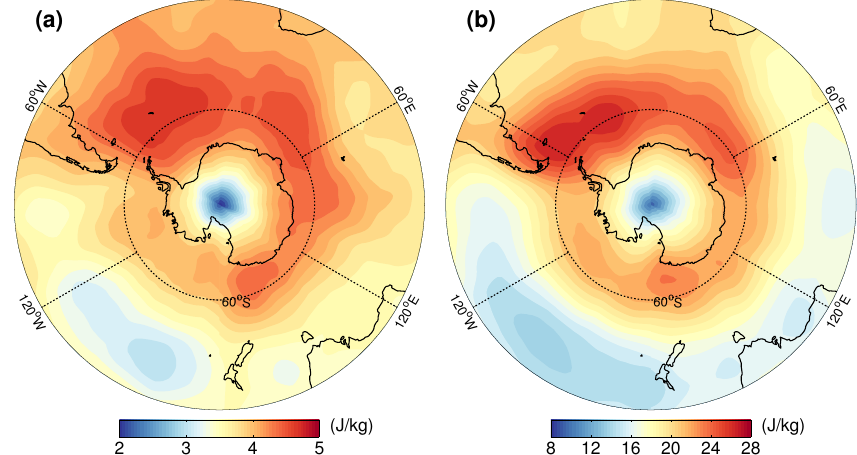
Figure 7. Polar stereo projections of E p at 30km ( ∼ 10hPa) for June–August 2006–2012 using (a) all available COSMIC profiles and (b) only individually identified waves using the Wave-ID method (see text).